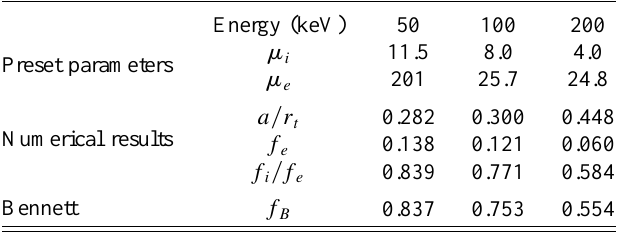
TABLE II. Comparison of Bennett’s solutions with numerical solutions at arbitrarily selected parameters: a (cid:3) r t is the rela- tive width obtained by fitting the space charge distributions to Eq. (2.8). The values of f e indicate decompression, and the cen- tral neutralization factor f i (cid:3) f e should be compared to Bennett’s f B in Eq.